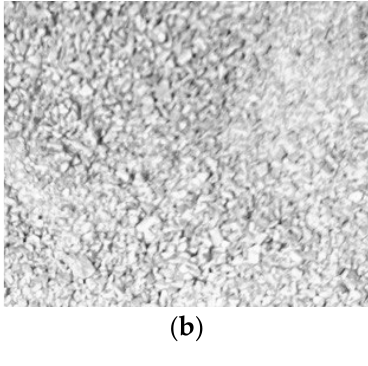
Table 1. Characteristics of the used